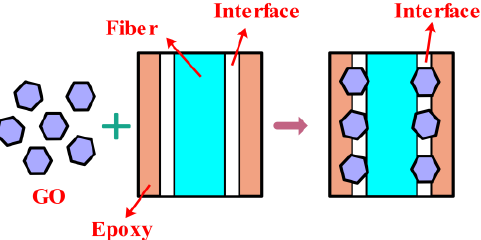
Figure 6. Schematic diagram of mechanical interlocking.